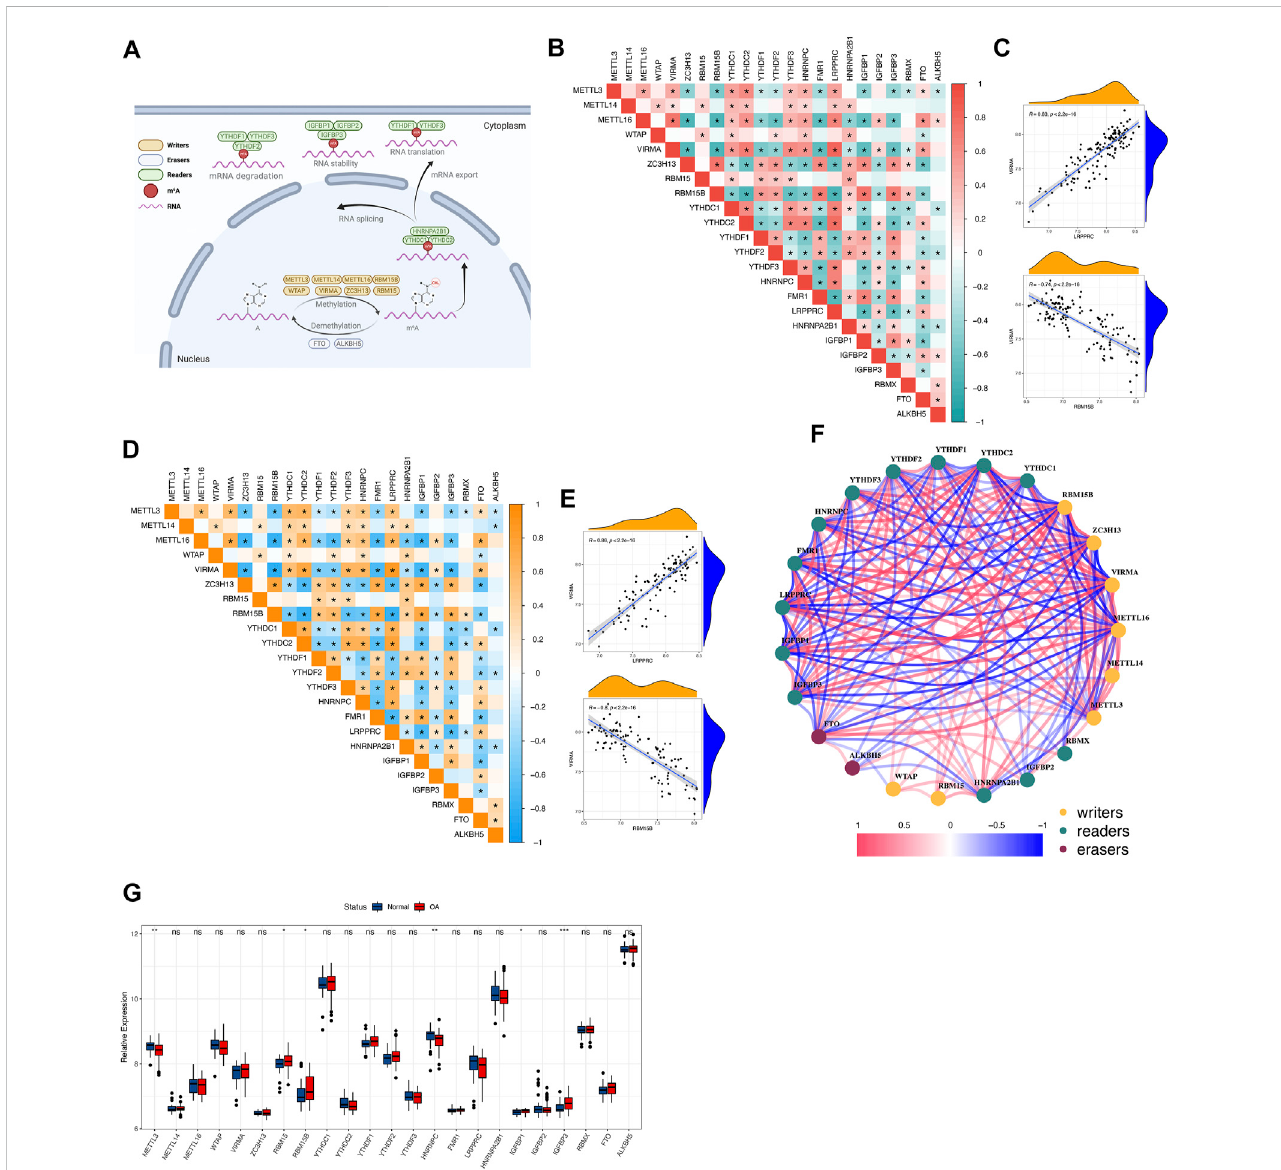
FIGURE 1 Thelandscapeofm 6 ARNAmethylationregulatorsinosteoarthritis (A) Overviewofthedynamicreversibleprocessofm 6 ARNAmethylationmodi fi cation regulatedby “ writers ” , “ erasers ” and “ readers ” inosteoarthritisandtheirpotentialbiologicalfunctionsforRNA. (B,C) Thecorrelationoftheexpressionof23m 6 A regulators in all samples. Red indicates a positive correlation, and green indicates a negative correlation. Two scatter plots showed the two mostrelevant sets of m 6 A regulators: VIRMA and LRPPRC werethe most positively correlated and VIRMA and RBM15Bwere themostnegatively correlated. Above* means p < 0.05. (D,E) The correlation of the expression of 23 m 6 A regulators in osteoarthritis samples. Orange indicates a positive correlation, and blue indicates a negative correlation. Two scatter plots showed the two most relevant sets of m 6 A regulators: VIRMA and LRPPRC were the most positively correlated and VIRMA and RBM15B were the most negatively correlated. Above * means p < 0.05. (F) The regulatory network of 23 m 6 A regulators in osteoarthritis: red indicates a positive correlation, and blue indicates a negative correlation. (G,H) The boxplot and heatmap show the expression of 23 m 6 A regulators between healthy and osteoarthritis samples. Above * indicates p < 0.05, ** indicates p < 0.01, *** indicates p < 0.001, and ns indicates that the difference was not statistically signi fi